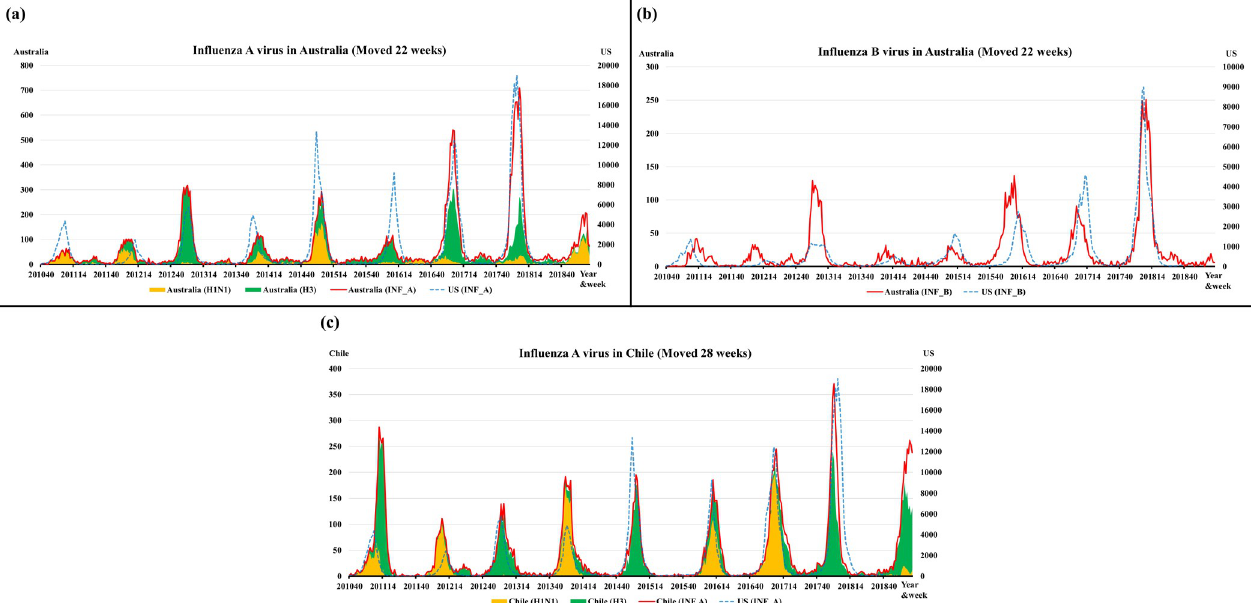
Fig 5. The surveillance data for influenza A (a) and B (b) viruses in the U.S. and Australia; the values for Australia were shifted forward 22 weeks in 2010–2018. The surveillance data for influenza A (c) viruses in the U.S. and Chile; the values for Australia were shifted forward 28 weeks. The blank part of the graph, the gap between INF A and the sum of the H1N1 and H3 viruses, is the number of influenza viruses (not subtyped).